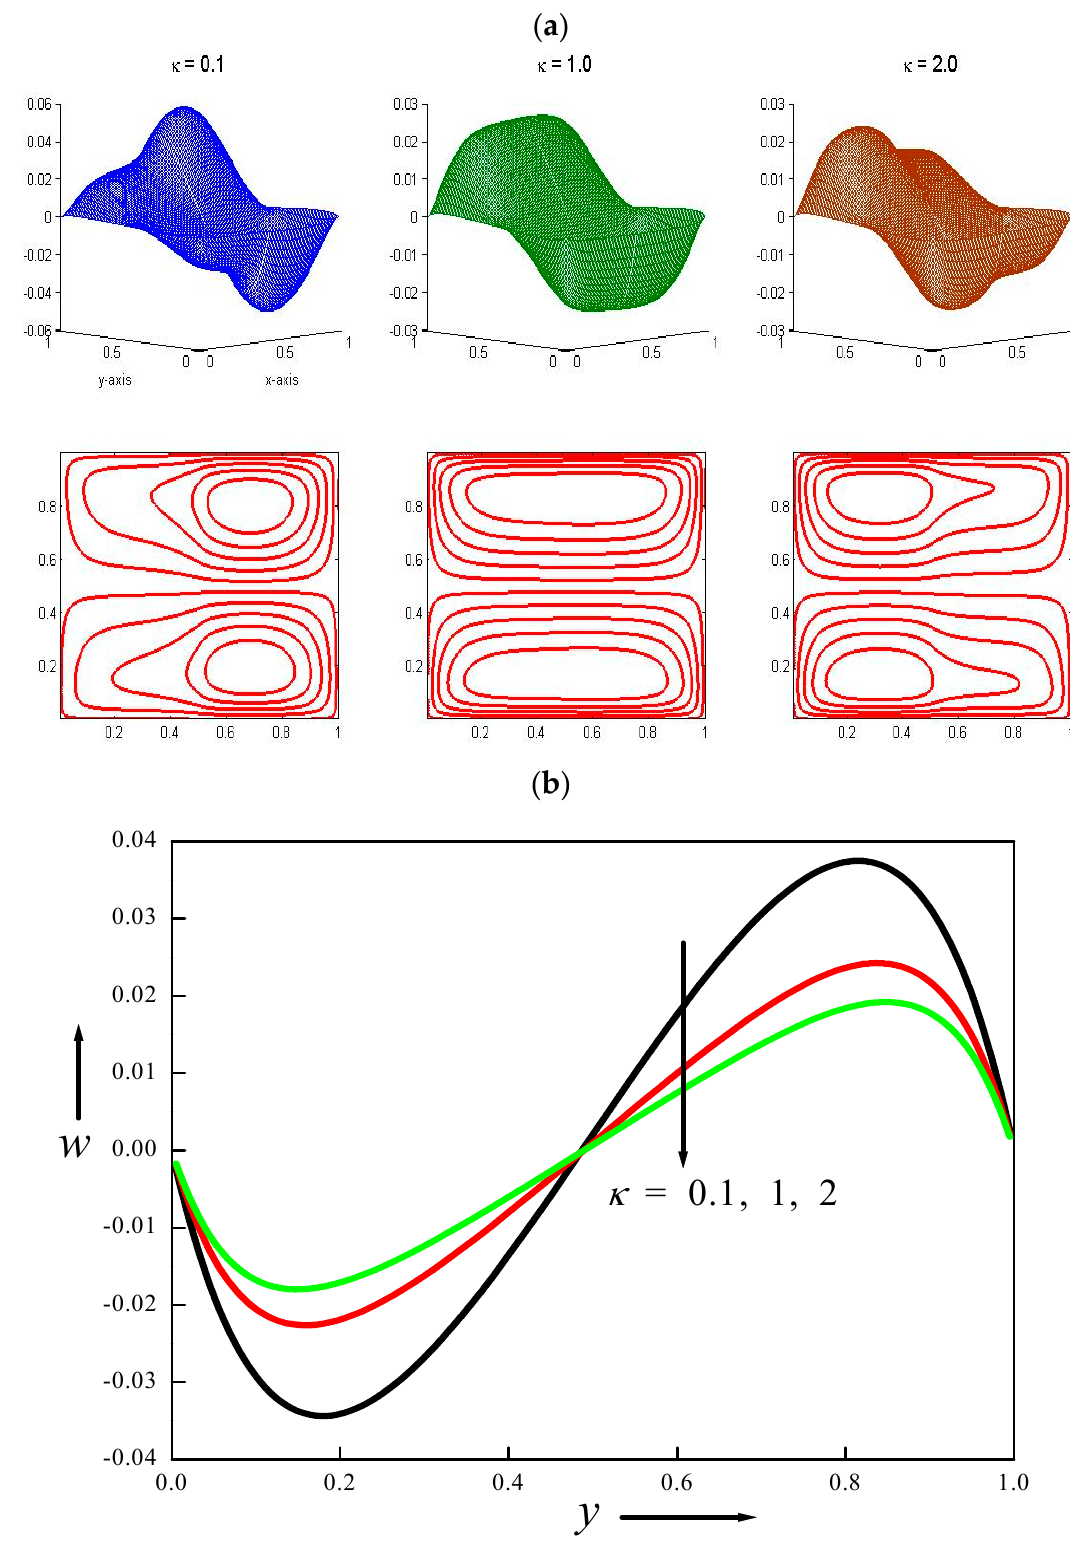
Figure 7. Velocity ( a ) contours ( b ) and profiles for altered ratio of permeabilities.